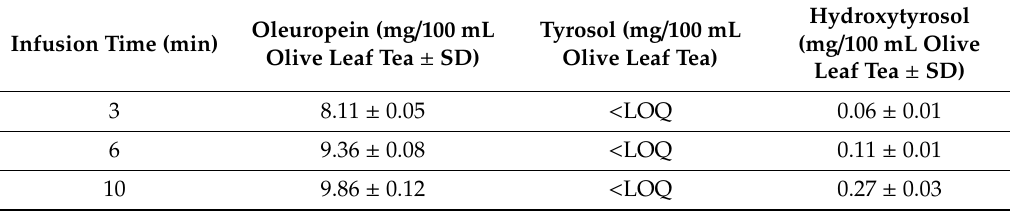
Table 5. Quantification results of oleuropein, tyrosol and hydroxytyrosol of olive leaves tea prepared in di ff erent infusion times in boiling